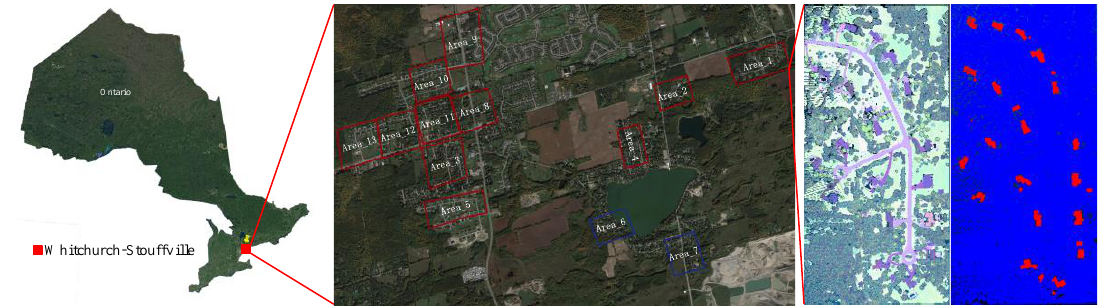
Figure 1. The study area, the general view of the selected scenes and a sample of the corresponding labeled data. Table 1. The size and total number of points in each selected scene.